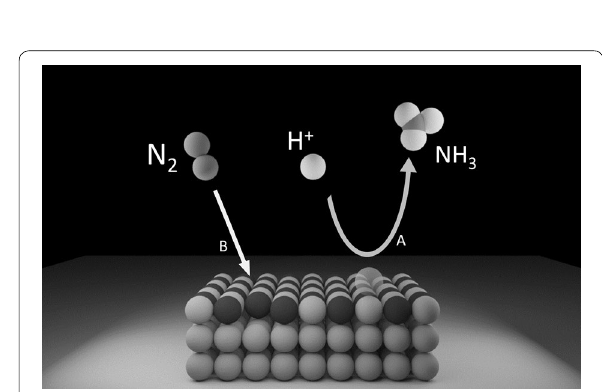
Scheme 1 Schematic for Mars‑van Krevelen reaction mechanism for